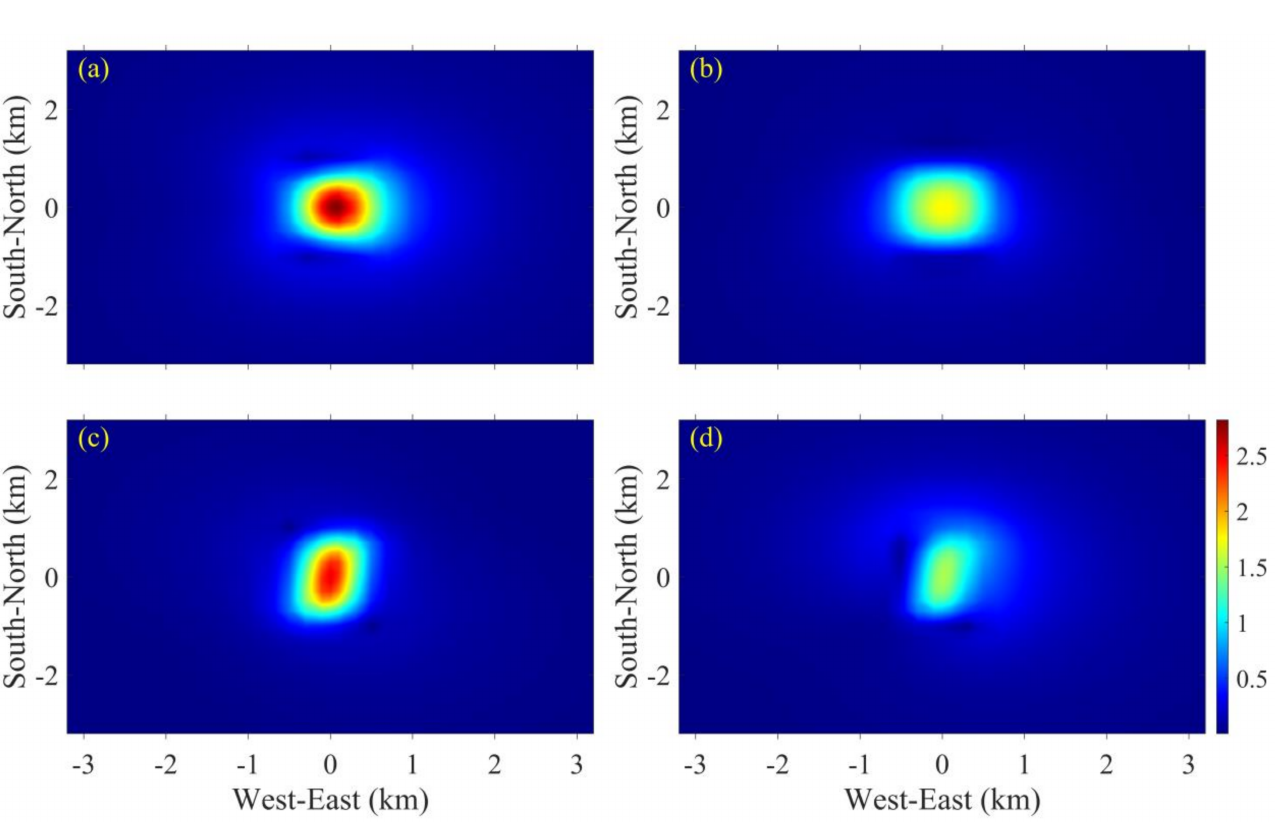
Figure 9. Anisotropy index of modified COMMEMI 3D-1A model for a frequency of 0.57 Hz. ( a ) Principal conductivity rotation around the x -axis by 30 ◦ . ( b ) Principal conductivity rotation around the y -axis by 30 ◦ . ( c ) Principal conductivity rotation around the z -axis by 30 ◦ . ( d ) Principal conductivity rotation around x -, y -, and z -axis by 30 ◦ .